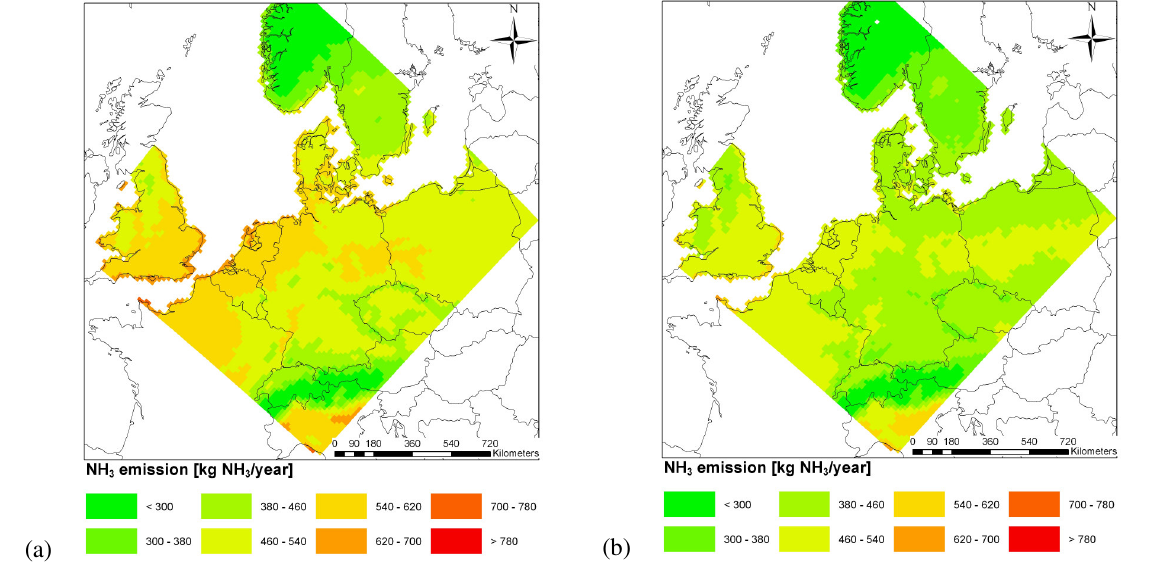
Fig. 2. Annual emission from storage facility in a pig farm with 1000 animals using average Danish production methods and exposed to different European climatic conditions in the years (a) 2007 and (b) 2010.